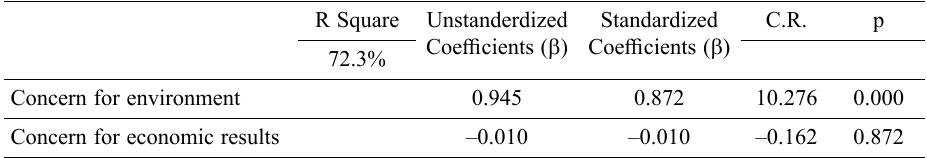
Table 2. Path analysis of managers’ attitudes on EER R Square